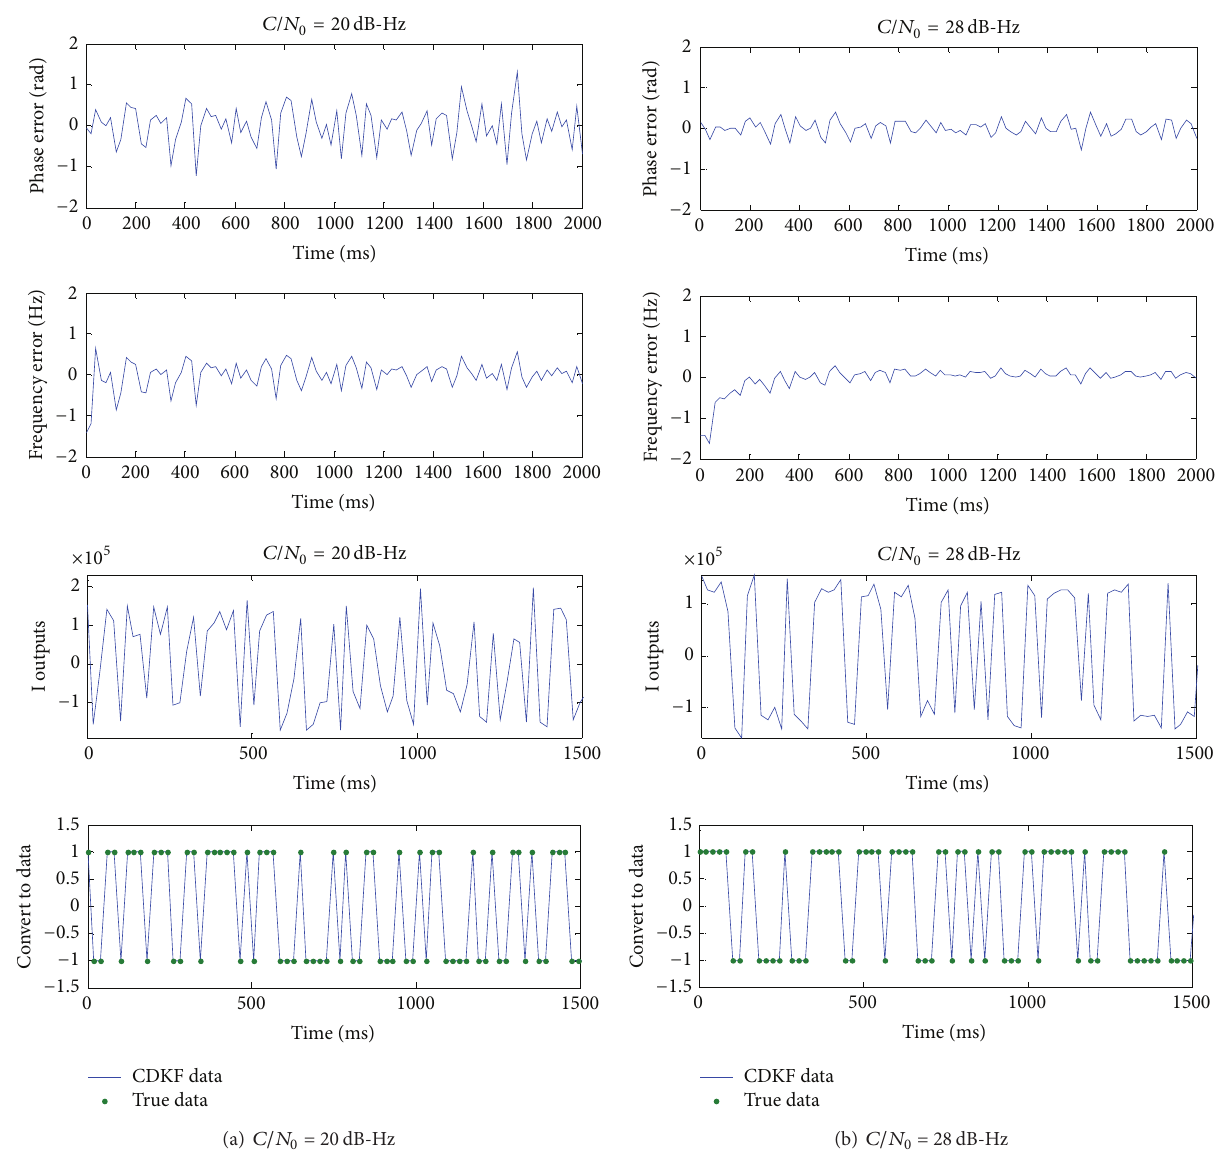
Figure 6: Estimated phase, frequency error history, and the first 75 data